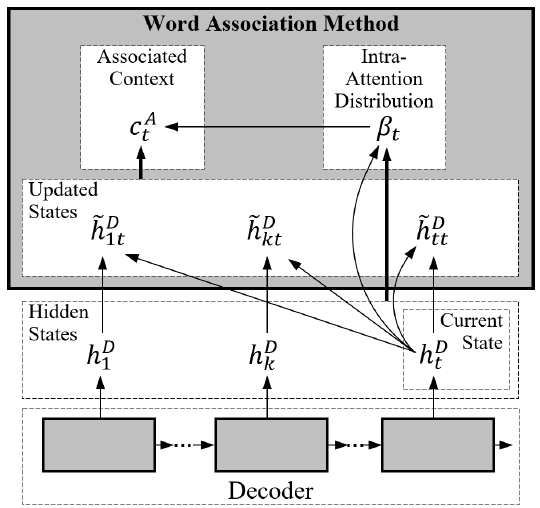
Figure 3. Detailed process of the word association method.